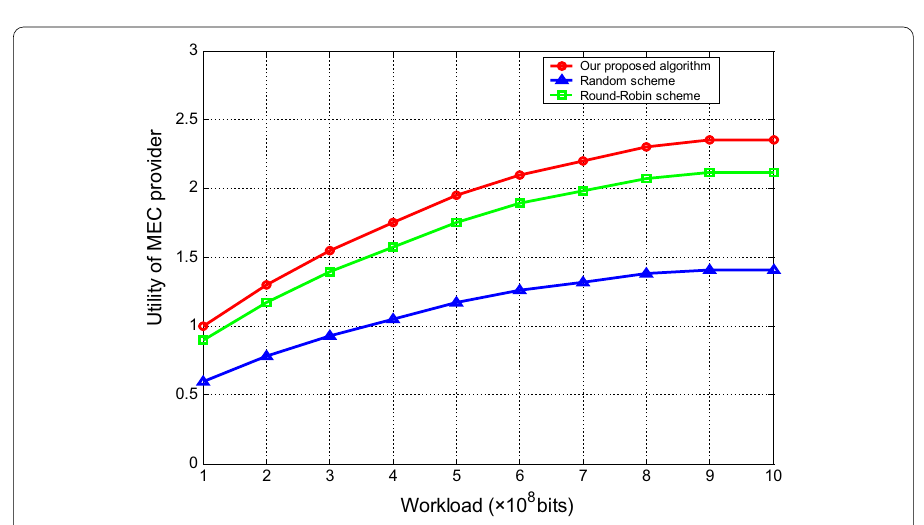
Fig. 4 Utility of MEC provider versus